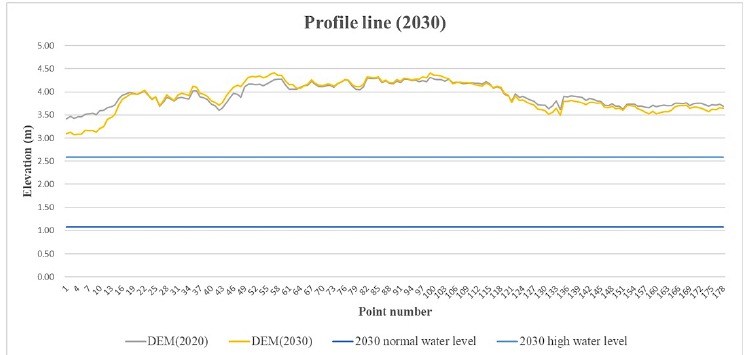
Figure 26. Static display of dam profile and sea-level for 2030. The highest sea-level is 2.58 m and the normal sea-level is 1.08 m. Remote Sens. 2020 , 12 , x FOR PEER REVIEW